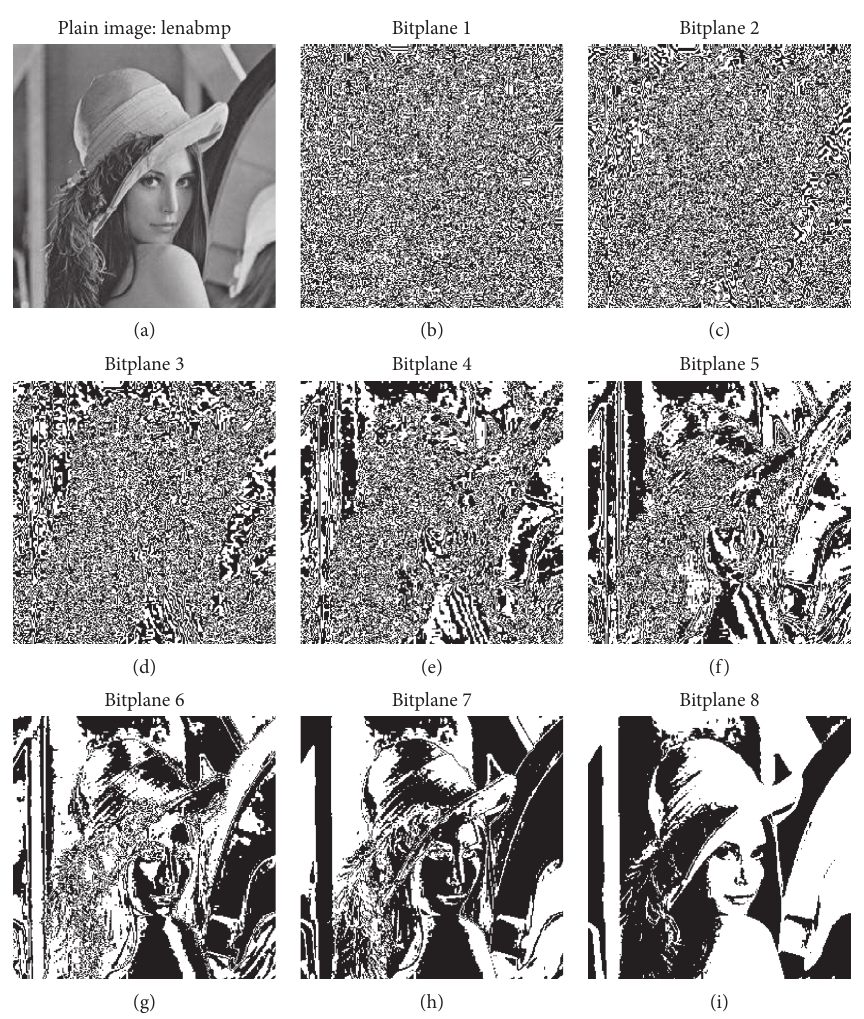
Figure 9: An 8-bit grayscale image with a size of 256 × 256 pixels.